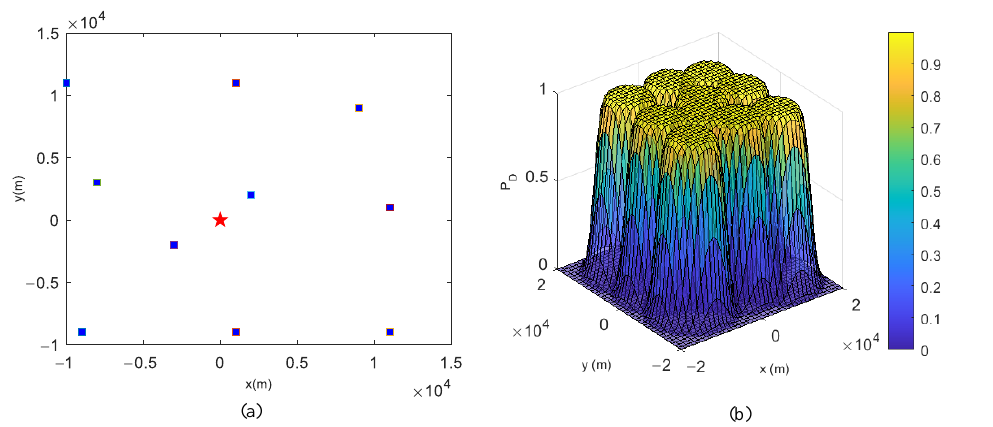
Figure 7. Simulation setup: ( a ) The locations of the transmitter (star) and receivers (squares); ( b ) con- tour plot of the probability of